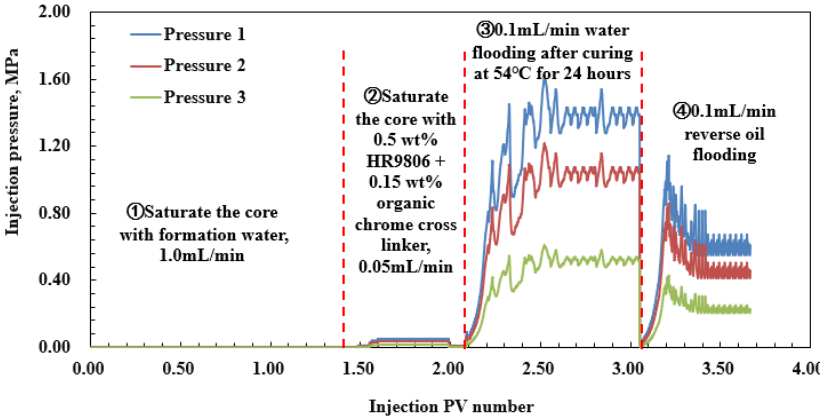
Figure 11. Pressure curves of 0.50 wt % HR9806 + 0.15 wt % crosslinker plugging and oil–water selectivity experiment [31].